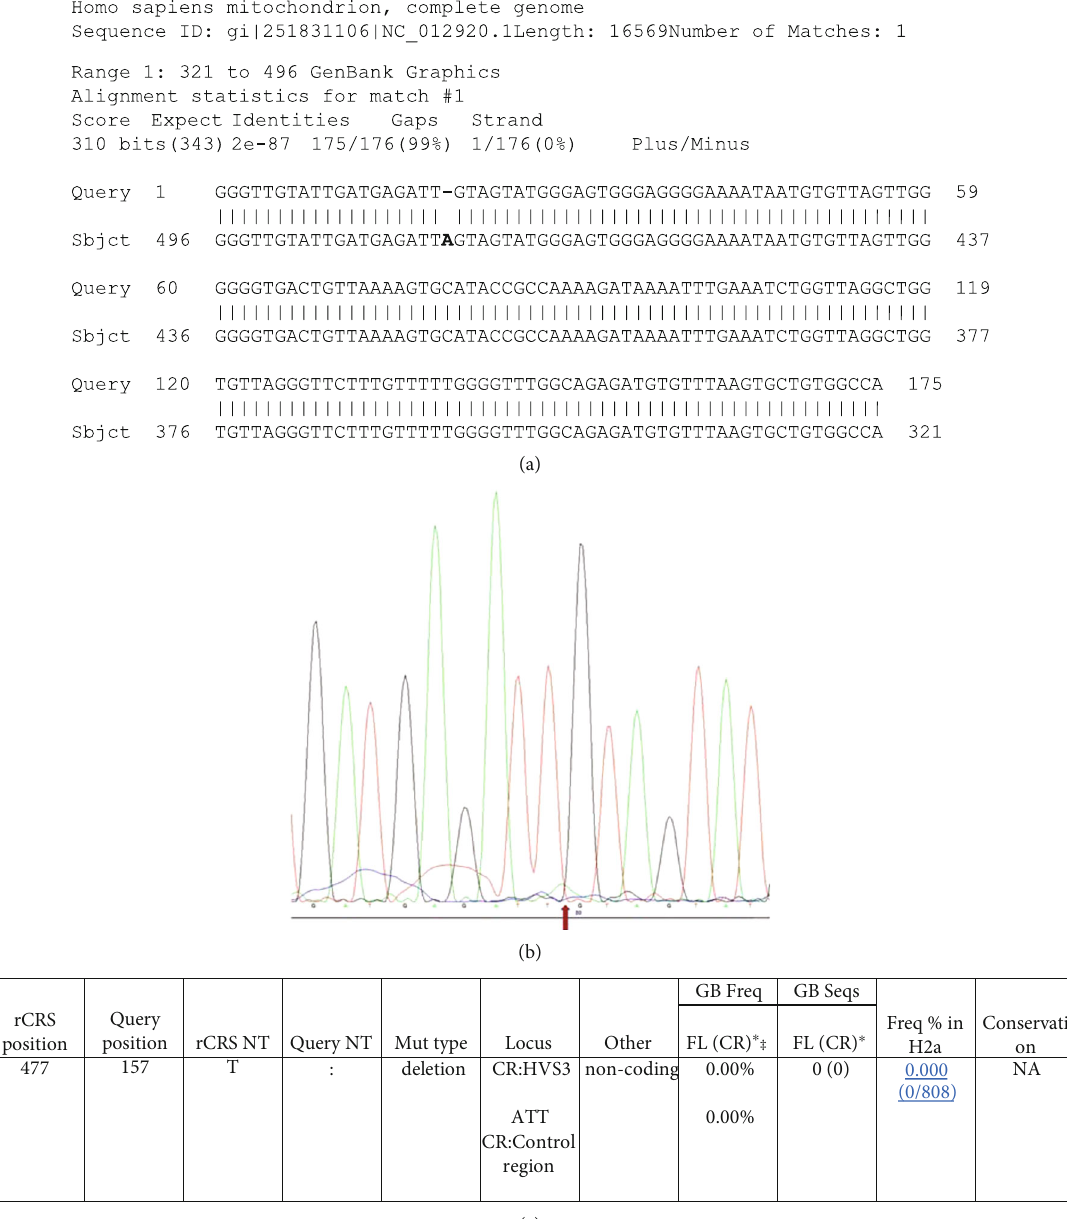
Figure 3: NSC exosome D-loop clone. (a) BLAST analysis against Homo sapiens mitochondrion, complete genome NC_012920.1. CD63+ exosomal mtDNA ampli fi ed with D-loop primers (location: 321-496). PCR products were cloned into the pCR4-TOPO-TA vector. (b) The red arrow in the sequence fi gure indicates the position of the nucleotide deletion in exosomal DNA in Homo sapiens mitochondrion complete genome sequence (NC_012920.1). The entire chromatogram of the clone is provided in the supplementary section (Figure S-7). (c) Singular SNP at 477 (A > -) found in the clone (bold letter in (a)) is also reported in MITOMAP at rCRS position 477 (T > -). Information from MITOMAP: ∗ the current GB frequency data is derived from two sets of human mitochondrial sequences from GenBank: 52,633 full-length (FL) sequences ( > 15.4 kbp) and 74,970 short, control region (CR) containing sequences (0.4-1.6 kbp); ‡ high- frequency haplogroups: variants found in haplogroups at 50% or higher are marked with a fl